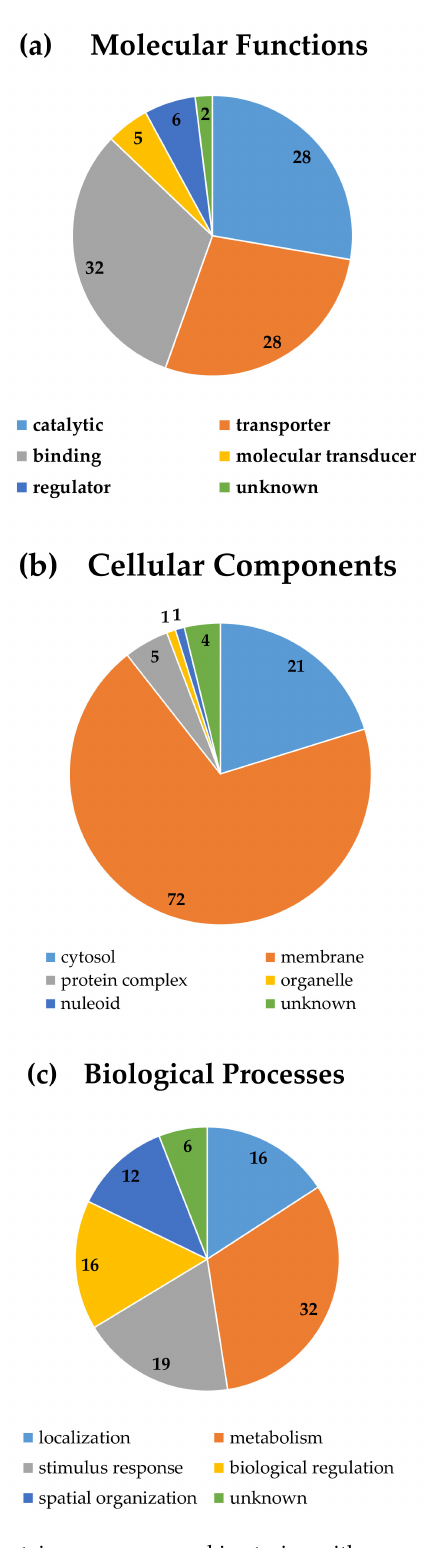
Figure 5. Gene ontology of proteins overexpressed in strains with severe growth effects. ( a ) Molecular functions; ( b ) Cellular components; and ( c ) Biological